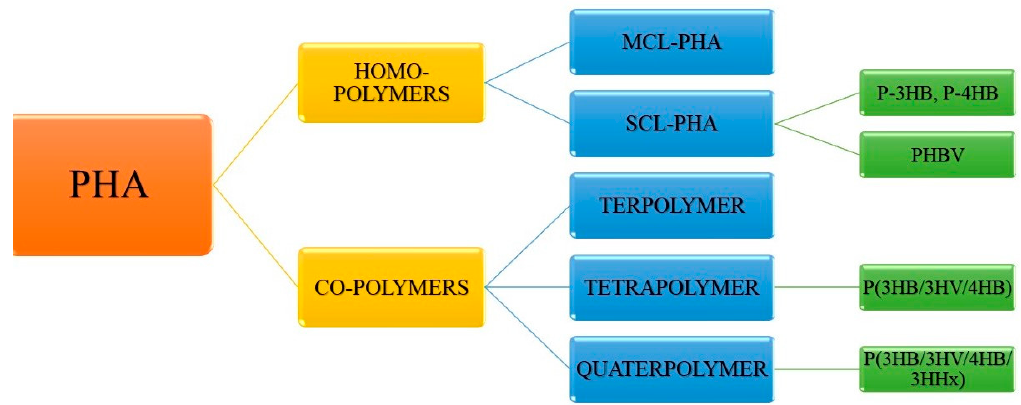
Figure 2. Classification helps in categorizing PHA into homopolymers and co-polymers. PHA: polyhydroxyalkanoate; PHB/P3HB: poly (3- hydroxybutyrate); PHBV: poly (3-hydroxybutyric acid-co-3-hydroxyvaleric acid)/polyhydroxybutyrate- co-valerate; P4HB: poly-4-hydroxybutyrate; MCL-PHA: medium-chain length polyhydroxyalkanoate; SCL-PHA: short-chain length polyhydroxyalkanoates.